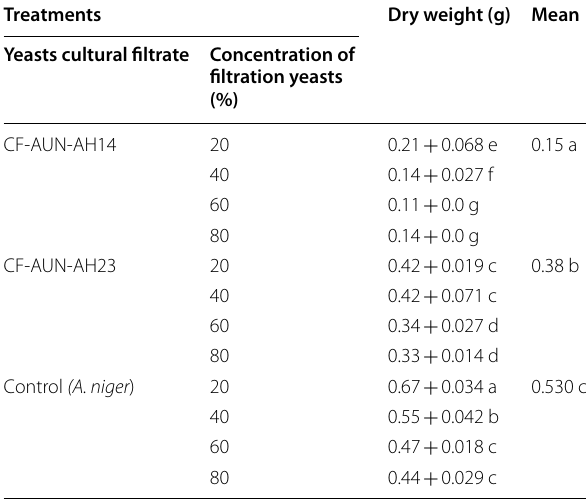
Values within the same column that are associated with different letters indicate significant differences ( P 0.05) based on two-way ANOVA. Four replicates were ≤ used in this experiment